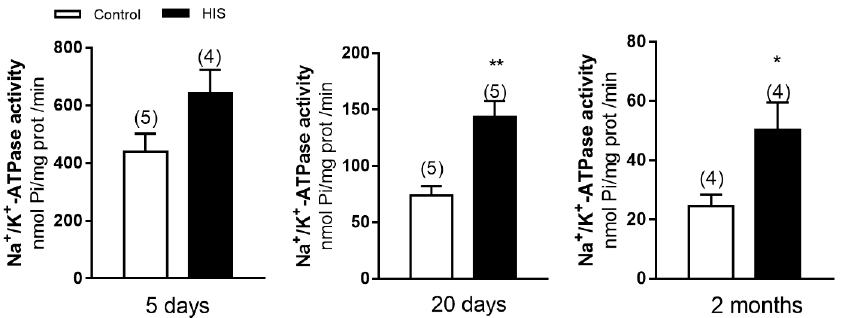
Figure 1. Status of Na + /K + -ATPase activity in neonatal cortex 5 and 20 days after HIS and in 2- month-old animals. Bar graphs show the effect of HIS on Na + /K + ATPase activity measured 5 days and 20 days after HIS (PD 17 and PD 32, respectively) and in 2-month-old animals (PD60). Data are mean ± S.E.M. values from 4 to 5 different animals from independent litters. * p < 0.05 and ** p < 0.01 are significantly different from control using unpaired two-tailed Student’s t